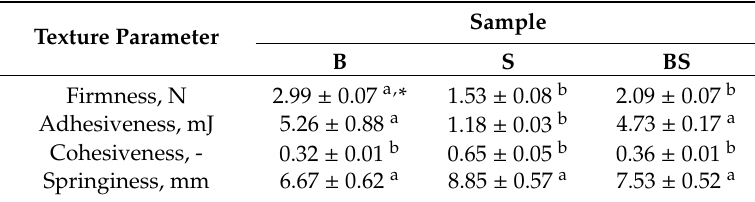
Table 3. Values of marmalade textural